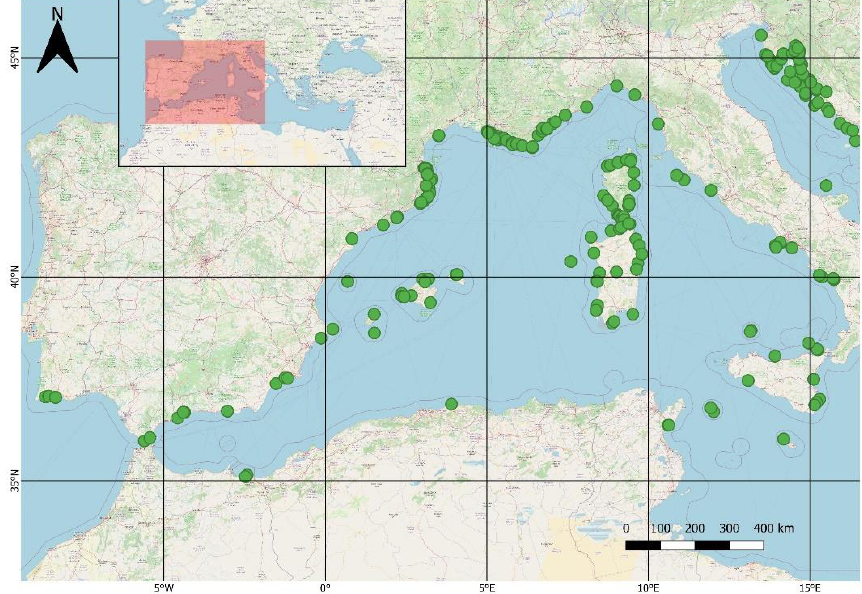
Figure 1. Records of Gobius incognitus in the western Mediterranean.